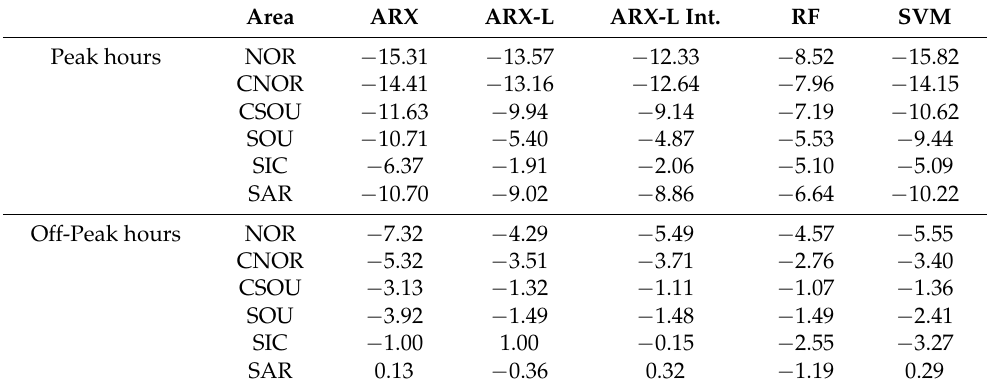
Table A4. Percentage variation of the mean values of MAE over peak and off-peak hours with respect to the case in which no exogenous variables were included in the regressors set.